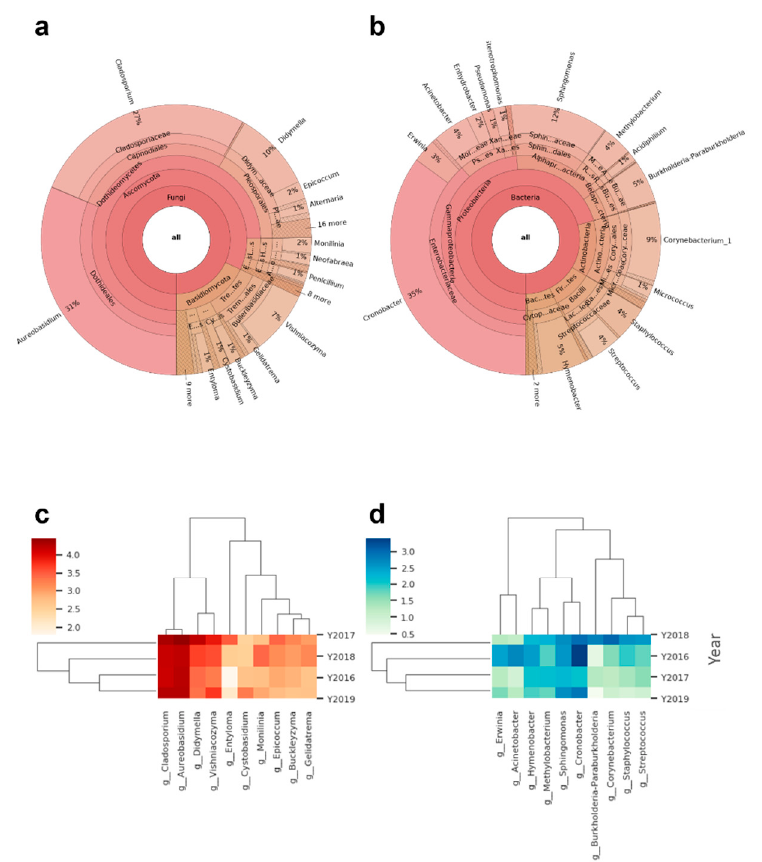
Figure 2. ( a ) Krona plot of all fungal and ( b ) bacterial reads in the dataset. ( c ) Heatmap of the ten most abundant fungal genera. ( d ) Heatmap of the ten most abundant bacterial genera within the dataset. The colors represent the frequency in log10 scale. The dendrogram of the genera was generated using UPGMA clustering and the dendrogram of the sampling years using the Bray–Curtis distance metric in Qiime2.